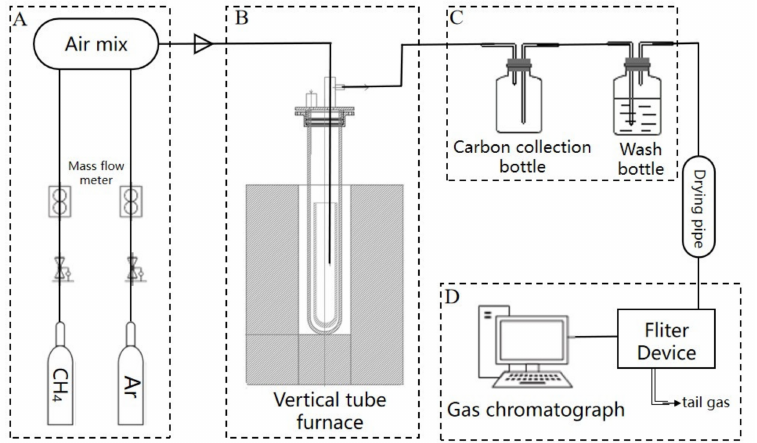
Figure 1. Diagram of the methane pyrolysis process: ( A ) air mix section; ( B ) reaction section; ( C ) carbon product collection section; and ( D ) reaction gas